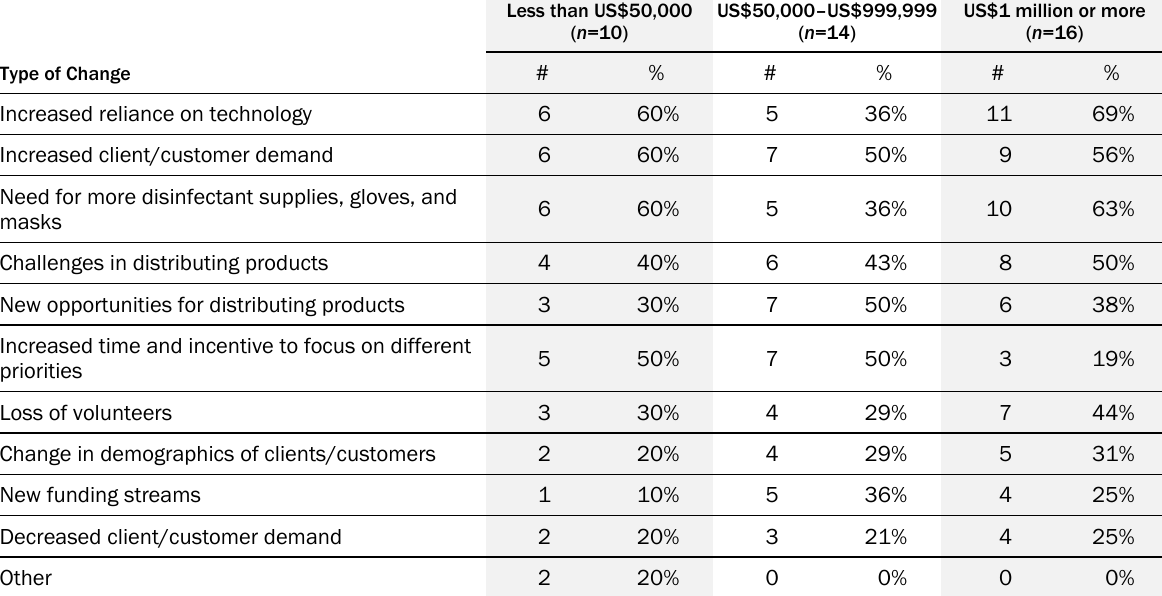
Table 4. Pandemic Impacts According to Organization or Business Budget